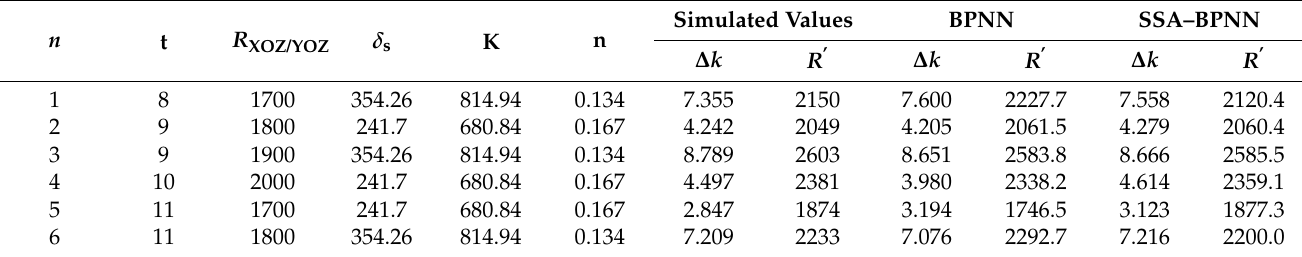
Table 8. Comparison of prediction results between BPNN and SSA–BPNN.